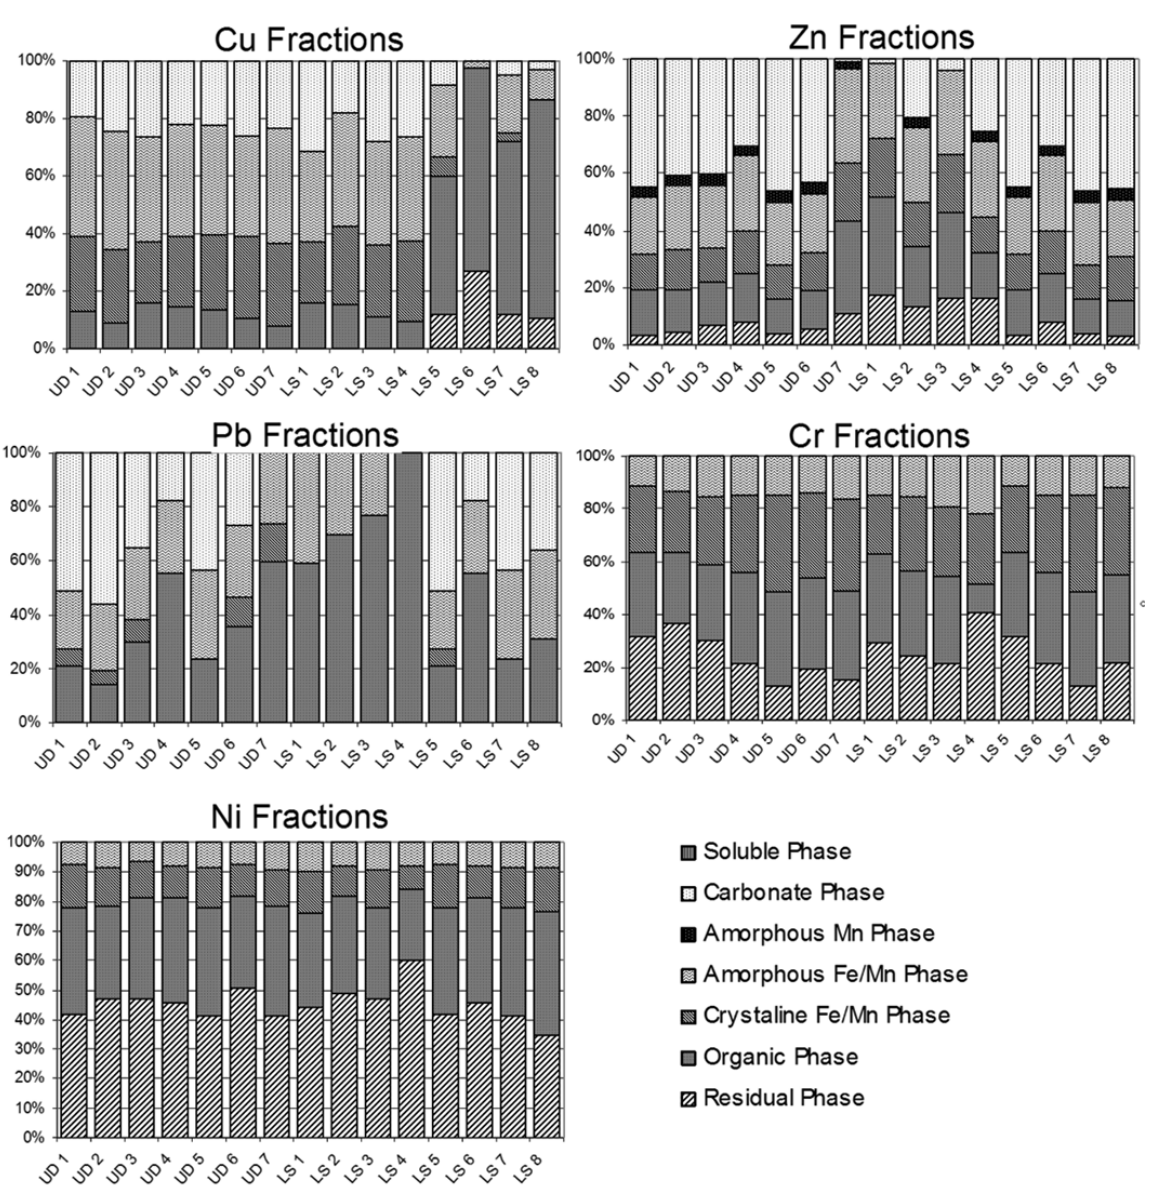
Fig. 4 – Heavy metal fraccionament during the 2 nd and 3 rd